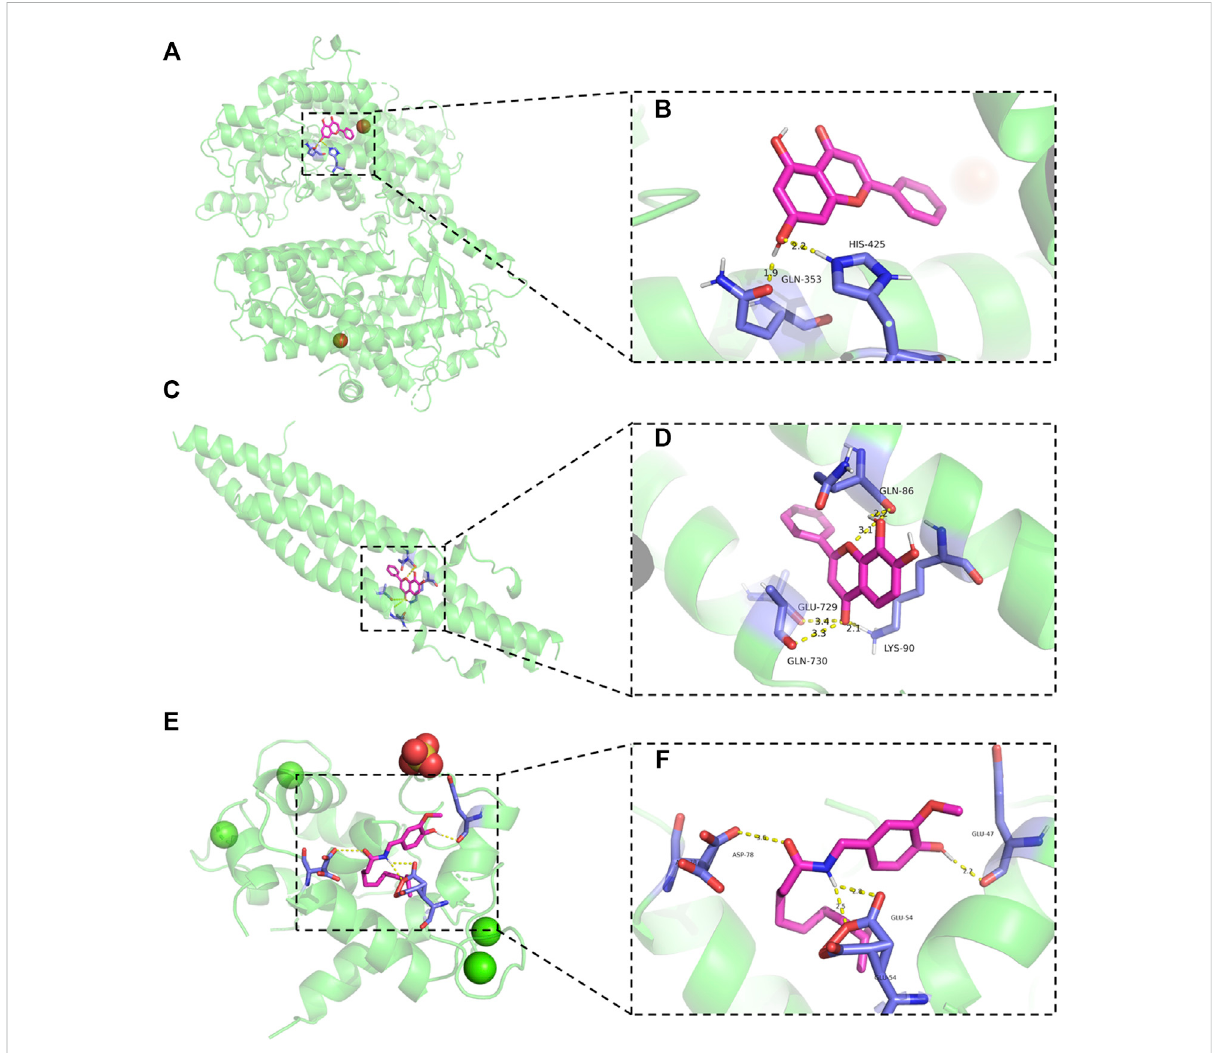
FIGURE 6 Molecular docking results. (A , B) Schematic diagram of the binding mode of chrysin to ALOX12 protein (left panels) and details of the binding pose (right panels). (C , D) Schematic diagram of the binding mode of 7,8-DHF to IKKB protein (left panels) and details of the binding pose (right panels). (E , F) Schematic diagram of the binding mode of DHC to TRPV1 protein (left panels) and details of the binding pose (right